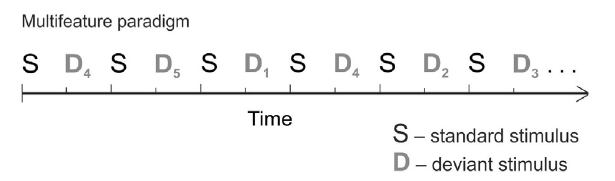
FIGURE 1 | The multifeature